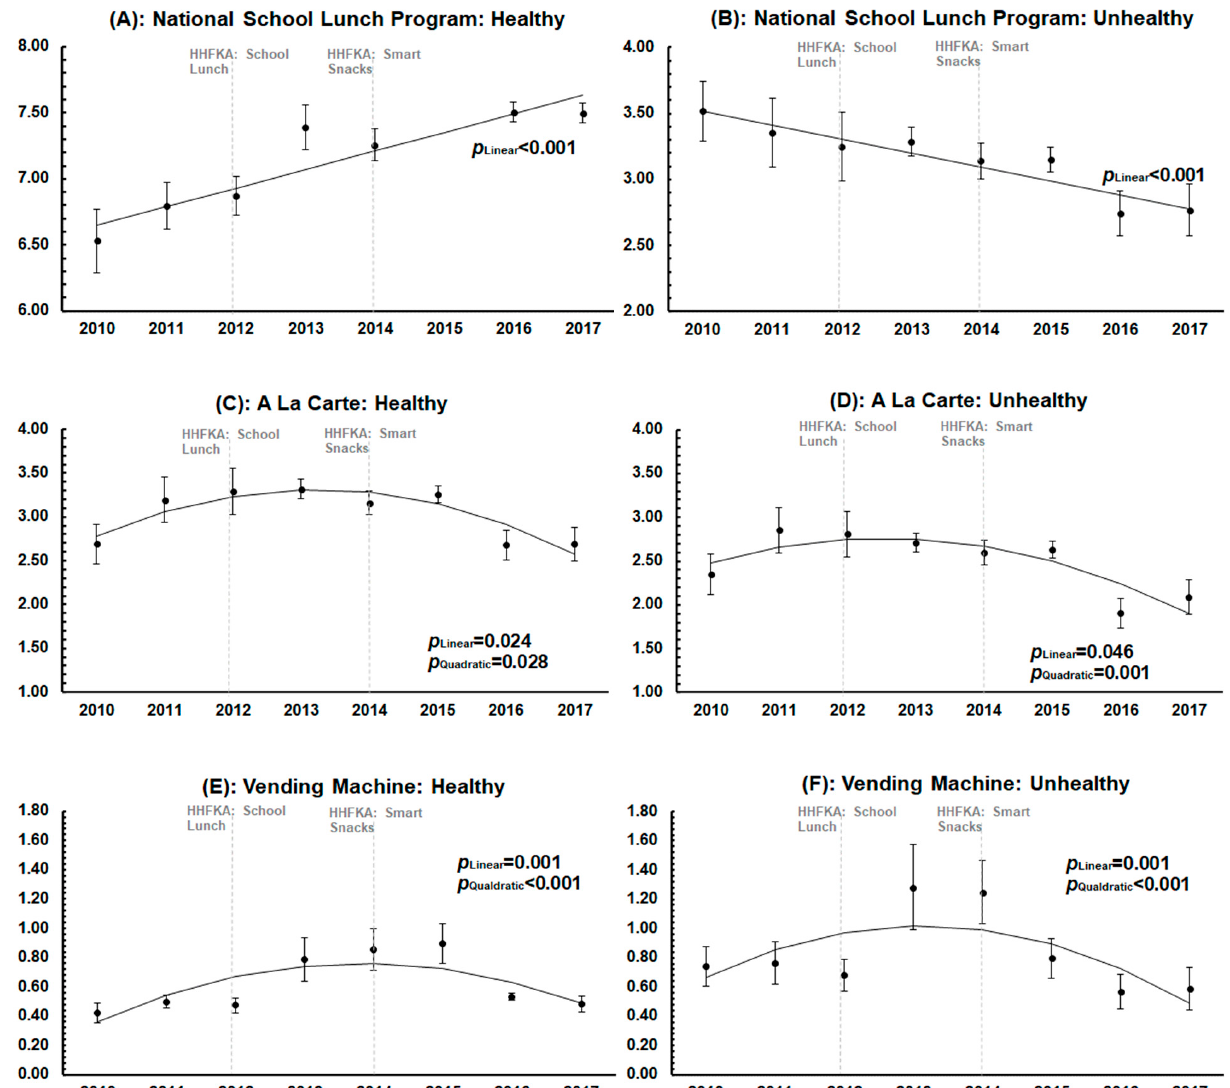
Figure 1. Year-by-year point estimates and predicted trends of each of the six food environment indices from school year 2010-11 to 2017-18 in the full sample. Dots represent the adjusted point estimates with confidence intervals estimated from the multilevel multivariable linear regression model. Lines represent the predicted line of best fit over the study period. The 2012 vertical line represents the implementation of the Healthy Hunger-Free Kids Act (HHFKA) guidelines for NSLP that occurred in 2012. The 2014 vertical line represents the implementation of the Smart Snacks guidelines (within the HHFKA) that occurred in